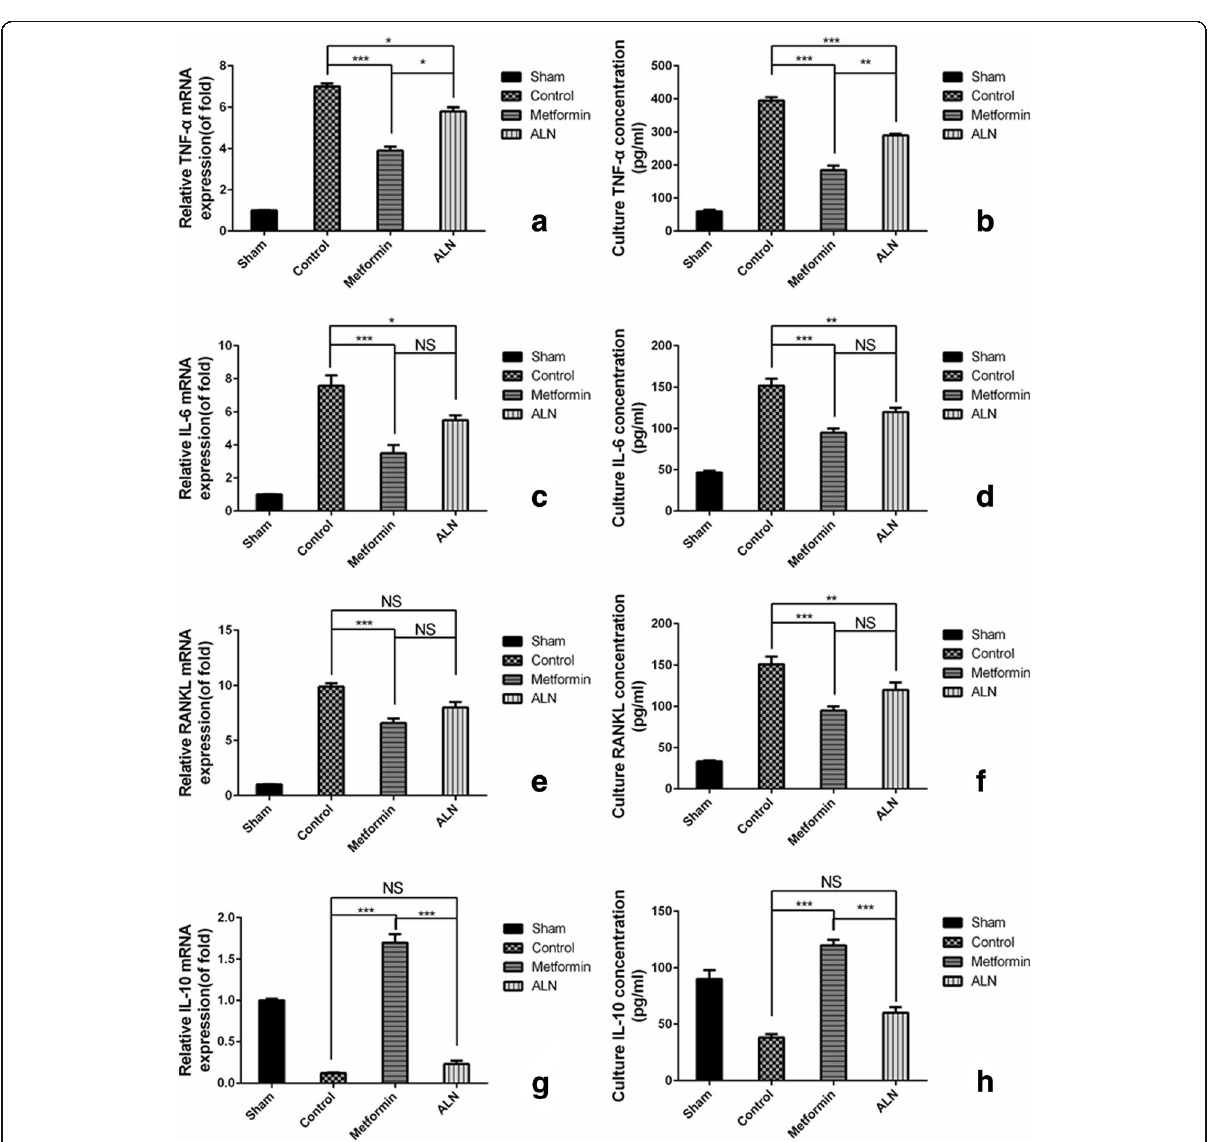
Fig. 5 mRNA expression and secretion of cytokines by mouse calvarial tissue after implantation of UHMWPE particles and treatment with saline (control), metformin, or ALN. Relative (to that in the sham group) expression of TNF- α , IL-6, RANKL, and IL-10 ( a , c , e , g , respectively) and secretion of TNF- α , IL-6, RANKL, and IL-10 ( b , d , f , h , respectively) among the different treatment groups. *** P < 0.001; ** P < 0.01; * P < 0.05; NS, P >